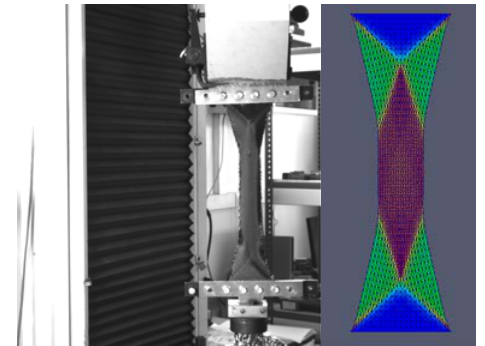
Fig6: Experimental and simulation results of bias test